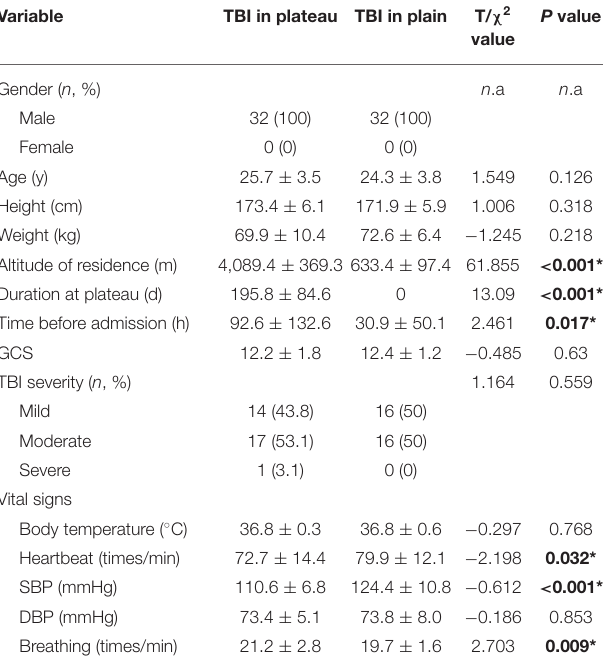
TABLE 1 | Demographic and clinical characteristics of patients with traumatic brain injury (TBI) in plateau and plain areas. Variable